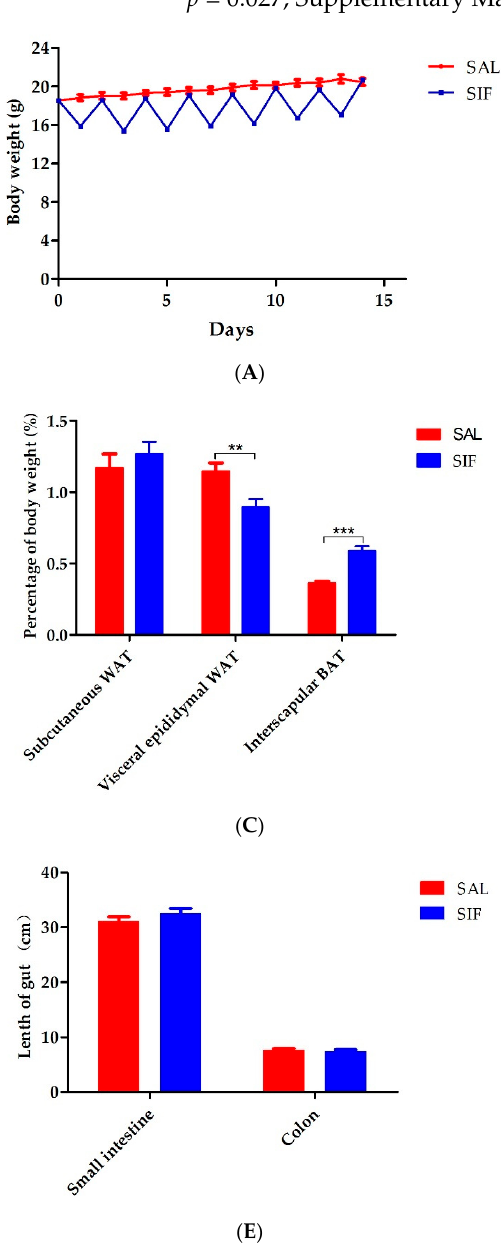
Figure 1. IF impacts the body weight and adipose tissue contents: ( A ) body weight with short-term IF; ( B ) body weight with long-term IF; ( C ) adipose tissue percentage of body weight with short-term IF; ( D ) adipose tissue percentage of body weight with long-term IF; ( E ) length of gut with short-term IF; and ( F ) length of gut with long-term IF. SAL: Short-term of ad libitum-fed group; SIF: Short-term of intermittent fasting group; LAL: Long-term of ad libitum-fed group; LIF: Long-term of intermittent fasting group. * p < 0.05, ** p < 0.01, *** p <